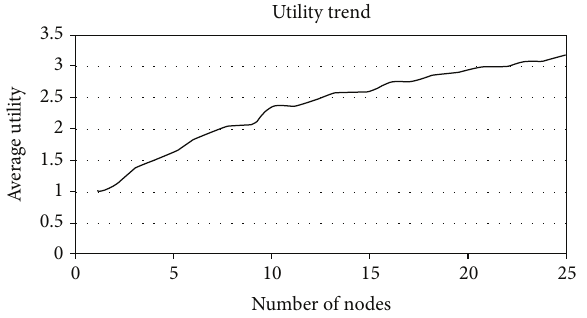
Figure 8: Utility of hormone-based model.